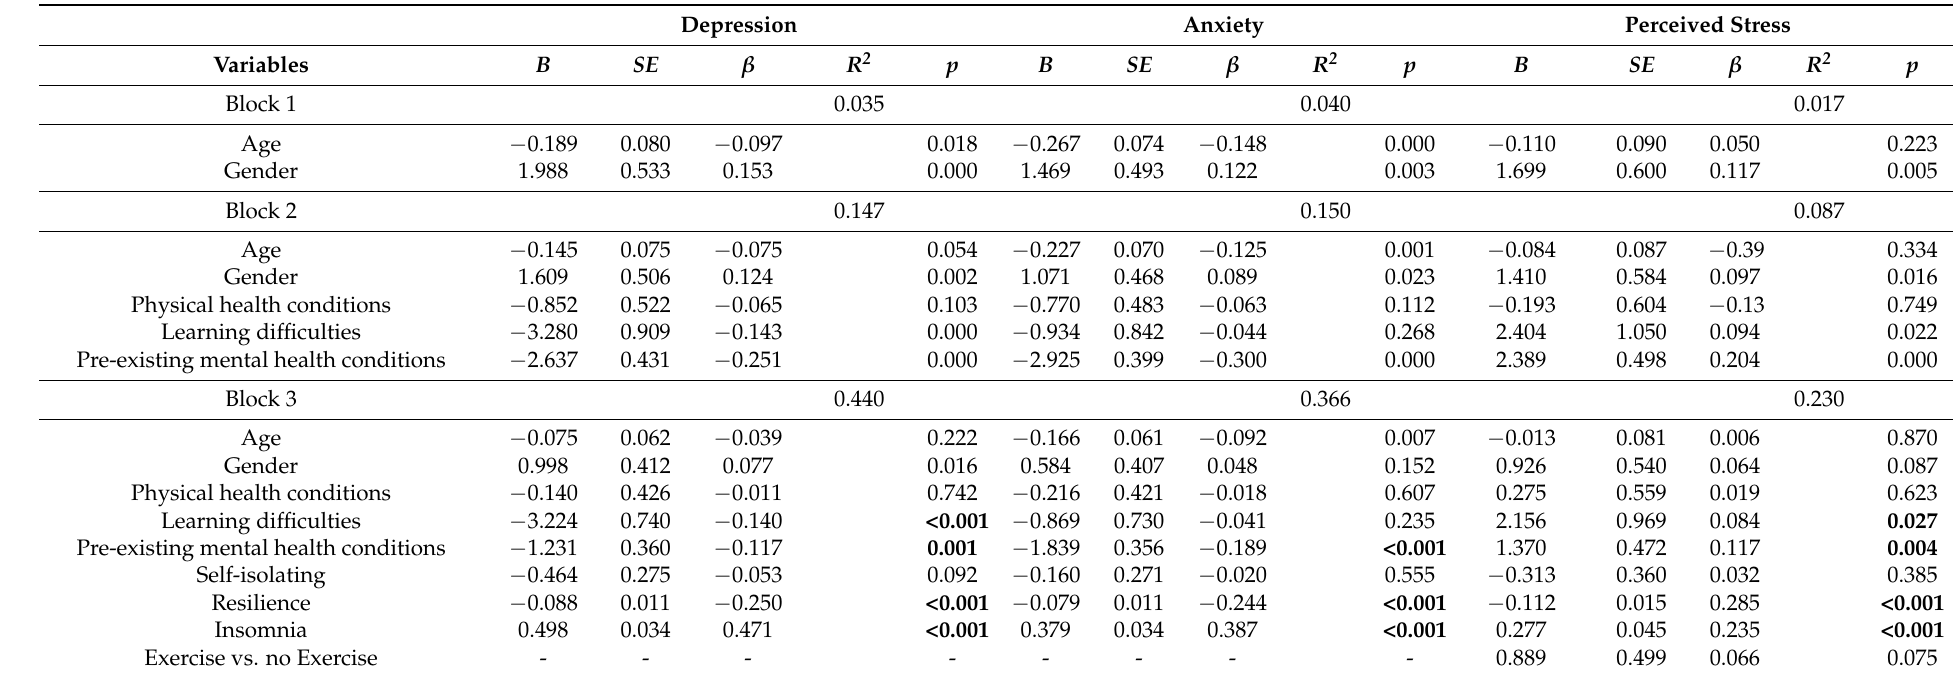
Table 3. Hierarchical regression predicting mental health